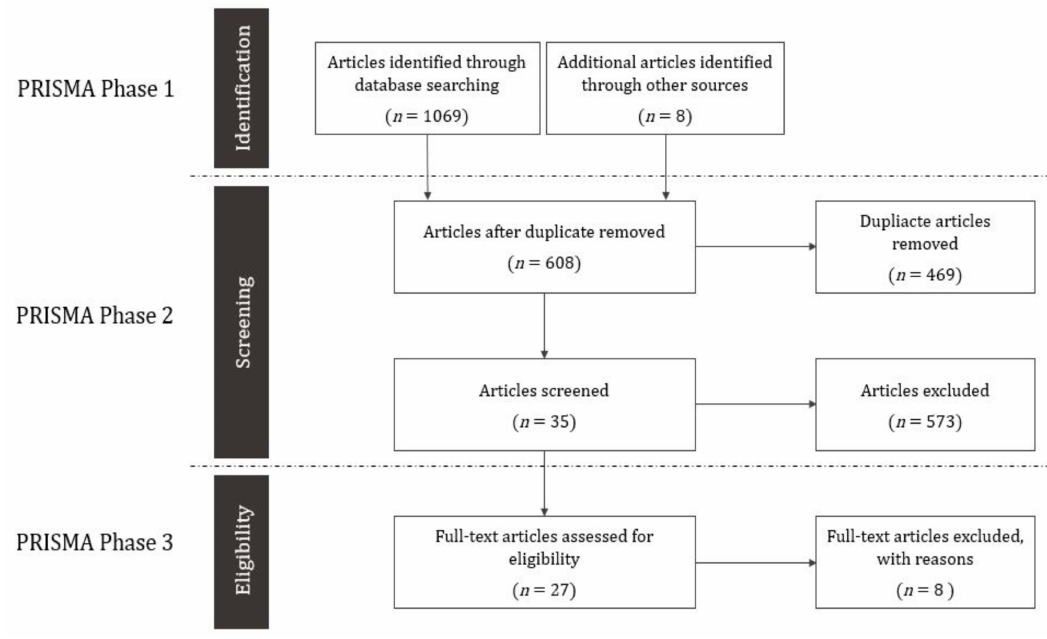
Figure 1. Flow diagram of the study